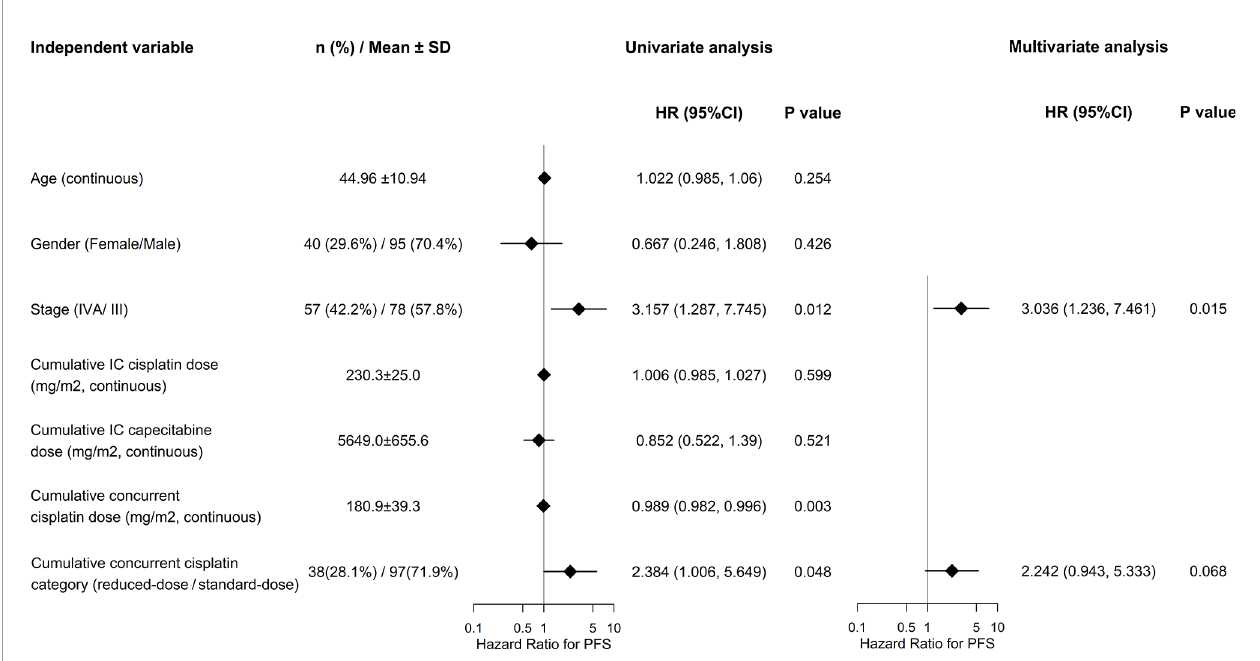
FIGURE 3 | Univariate and multivariate Cox regression on